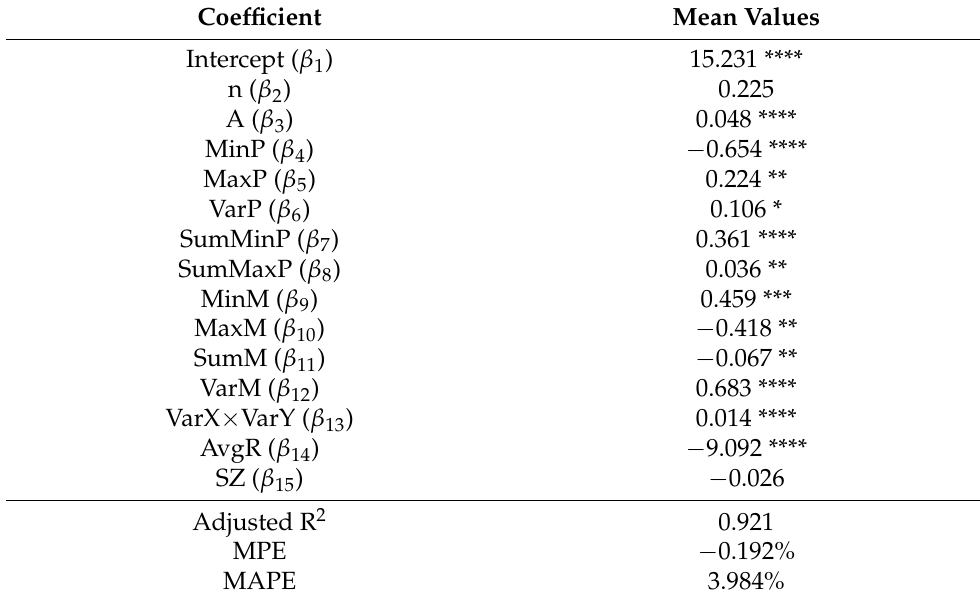
Table 2. Regression